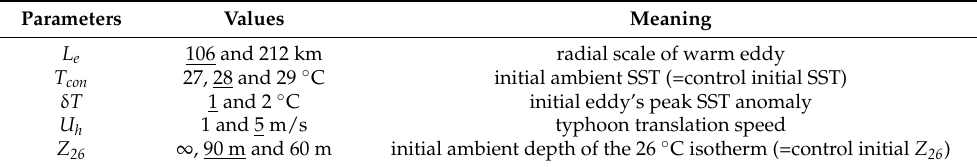
Table 2. Model parameters used in the 15 km × 15 km resolution ensemble experiments. Underlined are “standard” values typically observed in 10 ◦ –23 ◦ latitudes in western North Pacific, where most RI events occur [21].